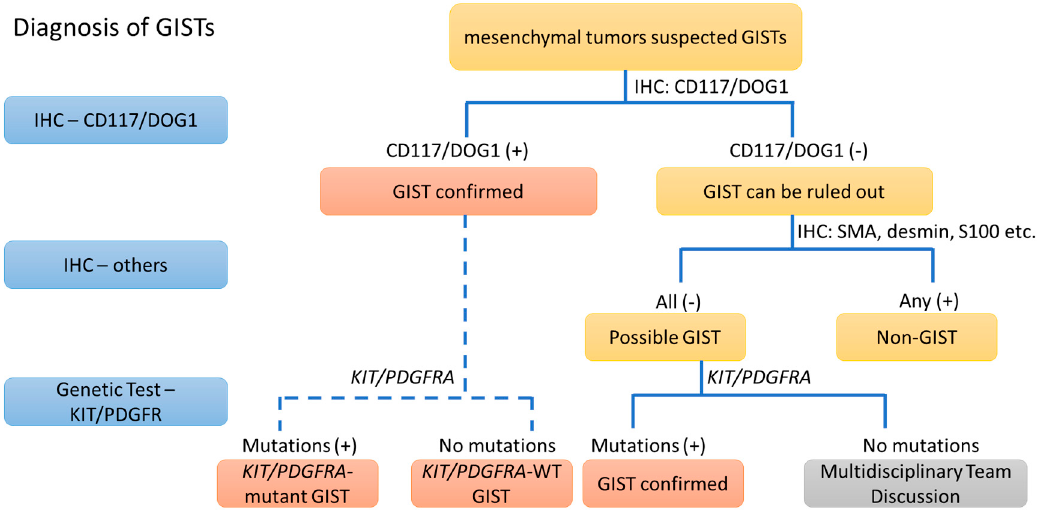
Figure 2. The diagnostic flow chart of GISTs by immunohistochemical staining and genetic